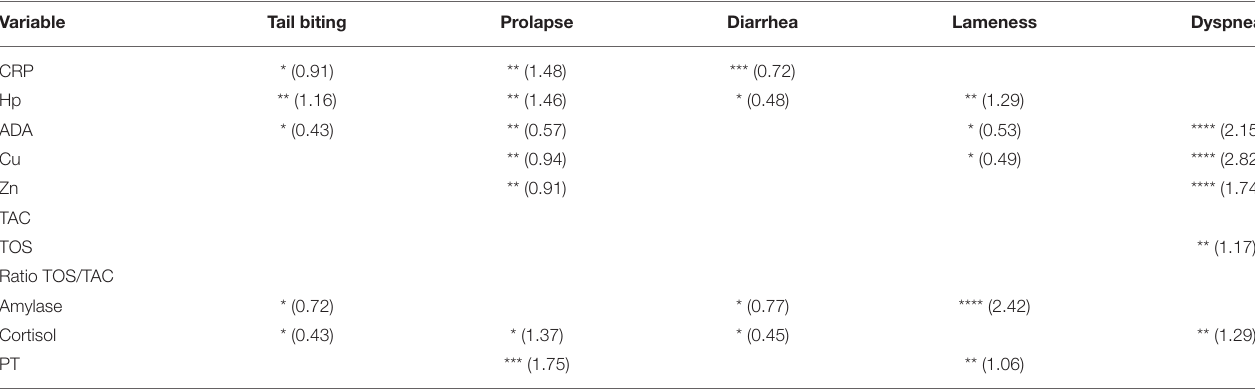
The size effect is represented as the coefficient Cohen’s d in brackets. For more information about exact p-values and statistical test used refer to Supplementary Table 1 . CRP, C-reactive protein; Hp, haptoglobin; ADA, adenosine deaminase; TAC, total antioxidant capacity; TOS, total oxidant status; TP, total